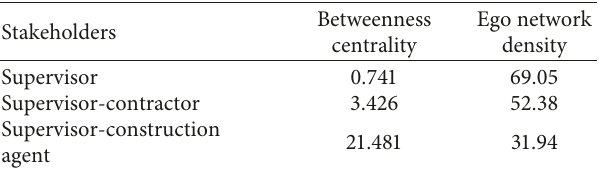
Table 5: Comparison of centrality and density between the three